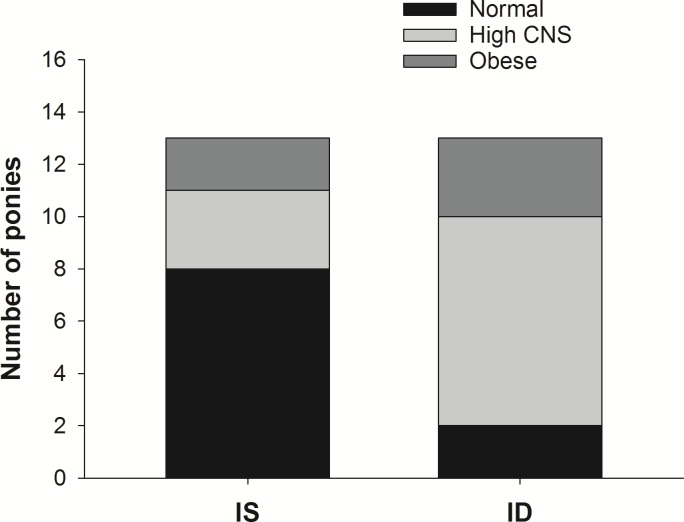
The relationship between generalised obesity, cresty neck score (CNS) and insulin status.Twenty-six ponies were diagnosed as having insulin dysregulation (ID) or not (IS) based on an oral glucose test, and were grouped according to body type. The diagnostic threshold for post-prandial insulin concentration was ≥80 μIU/mL.